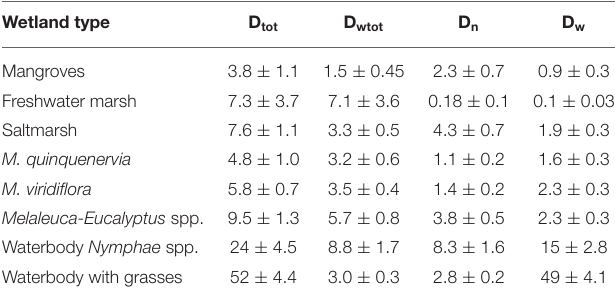
TABLE 3 | Denitrification rates (D t , total denitrification; D wtot , denitrification corrected for N additions; D n coupled denitrification-nitrification, D w , denitrification of NO − 3 -N from the water column; mg m − 2 h − 1 ).